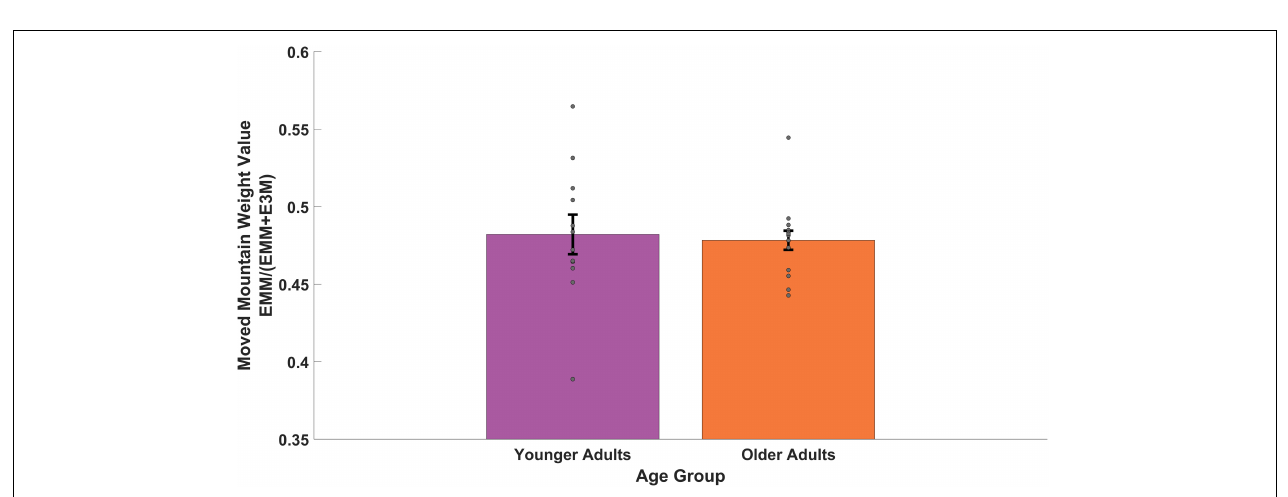
FIGURE 5 | Memory for target location compared to the actual location for same and different start points during probe trials. The two same trials (65 and 70) were matched with two different trials (66 and 67) for all younger adults and older adults. Gray dots represent individual subject data, bars indicate the mean distance error, and error bars represent the standard error. YAs performed better than OAs with both groups doing better on different (or novel) viewpoints than same (or repeated) viewpoints.